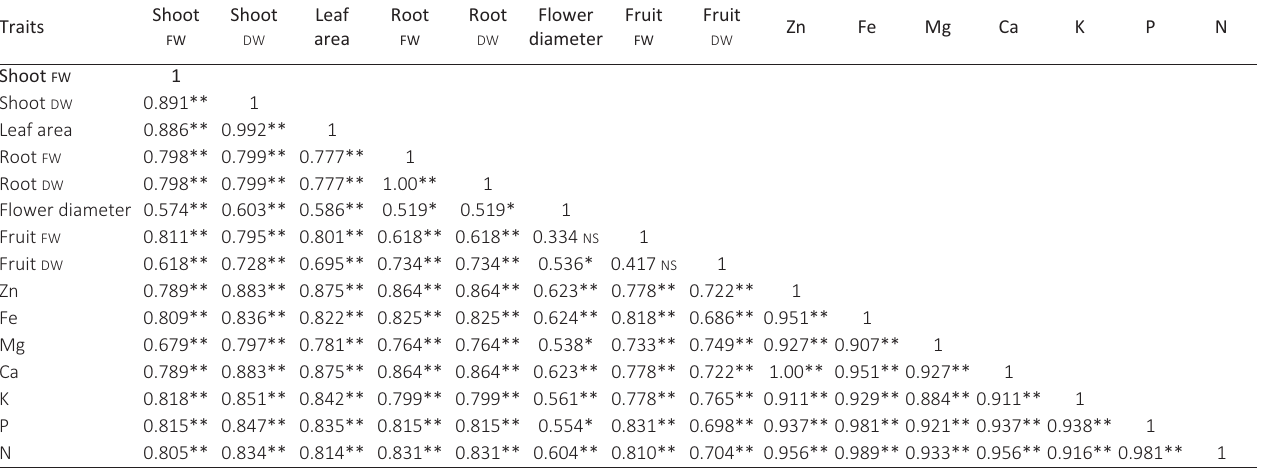
Table 9 - Correlation coefficients for evaluated traits on pot marigold in vermicompost treatment